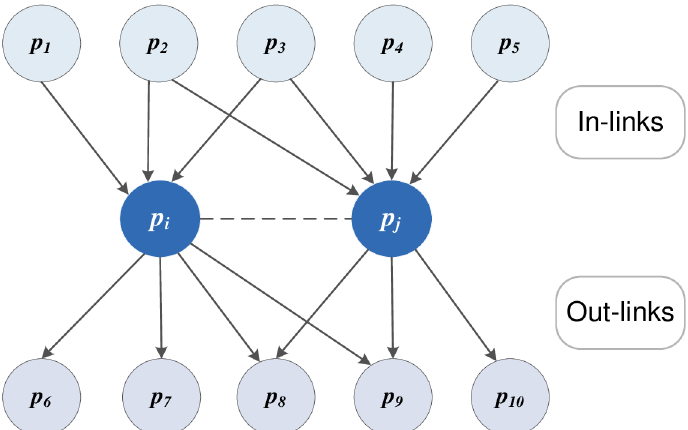
Fig 2. In-links and out-links between two papers. p 1 , p 2 , and p 3 representsthe citations of the paper p i , while p 2 , p 3 , p 4 , and p 5 represent the citations of the paper p j ; therefore, p 2 and p 3 are the common in-links between p i and p j . Similarly, p 6 , p 7 , p 8 , and p 9 represent the references of the paper p i , while p 8 , p 9 , and p 10 representthe references of the paper p j ; therefore, p 8 and p 9 are the common out-linksbetween p i and p j .